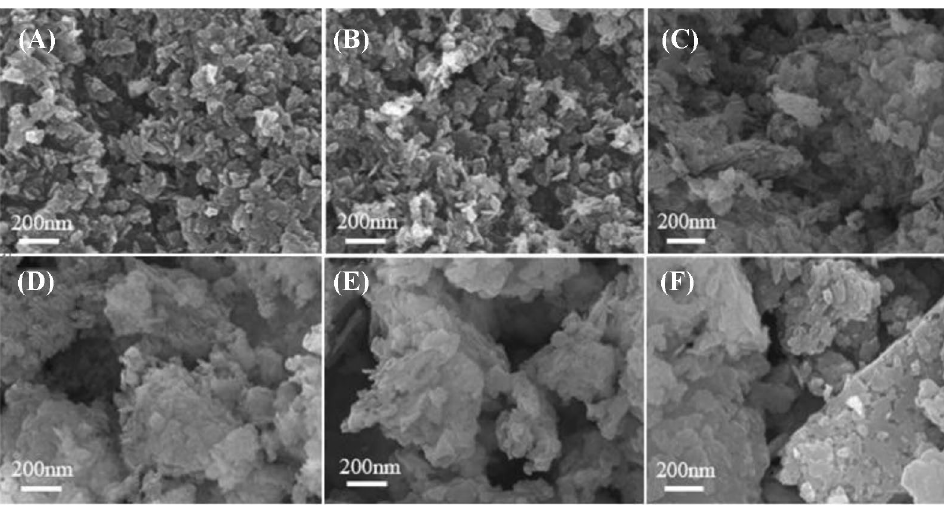
Figure 6. SEM images of ( A ) MgO-P-NaOH-3, ( B ) MgO-P-NaOH-6, ( C ) MgO-P-NaOH + Na 2 CO 3 -3/1, ( D ) MgO-P-NaOH +